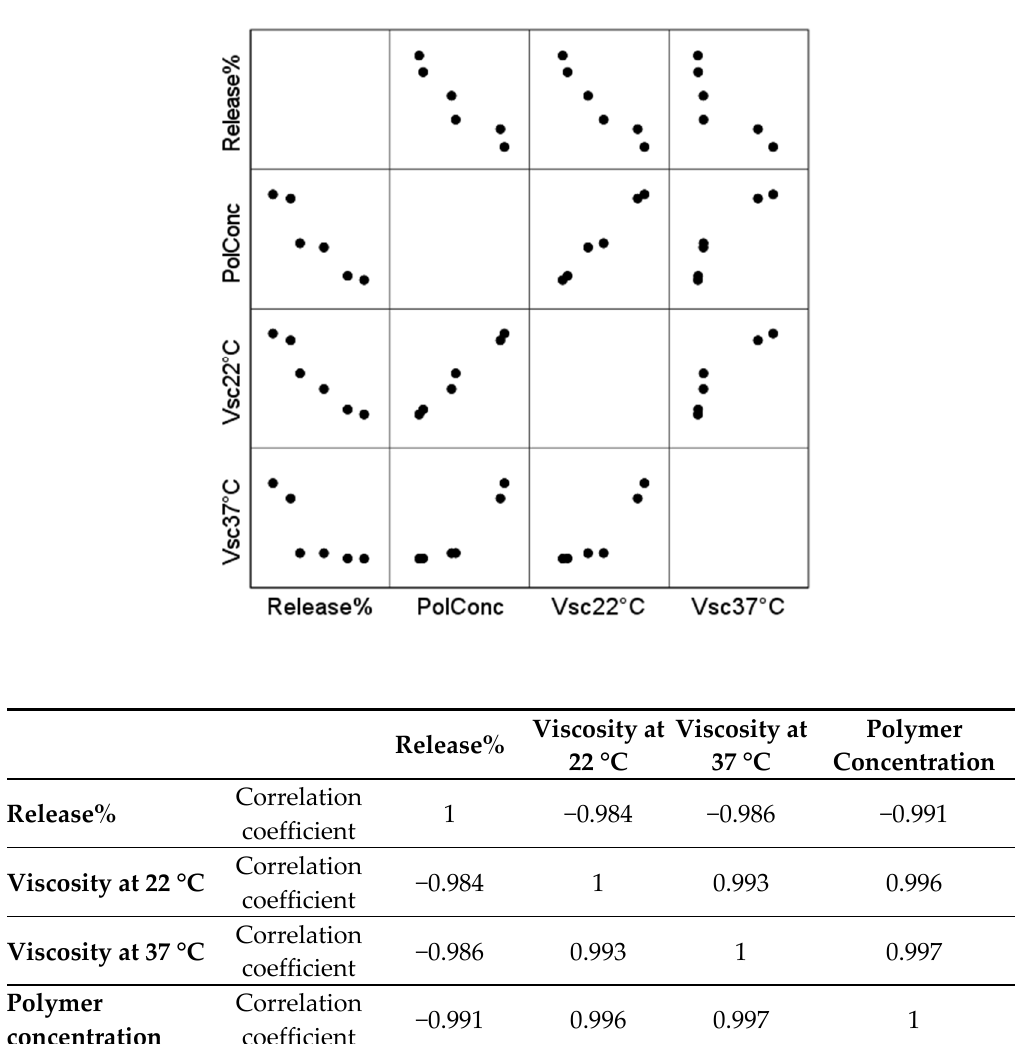
Figure 10. Correlation graph of total percentage release of phenolic compounds, viscosity at 22 °C, viscosity at 37 °C, and total polymer concentration ( w / v ), as measured by Spearman’s rank correlation coefficient.